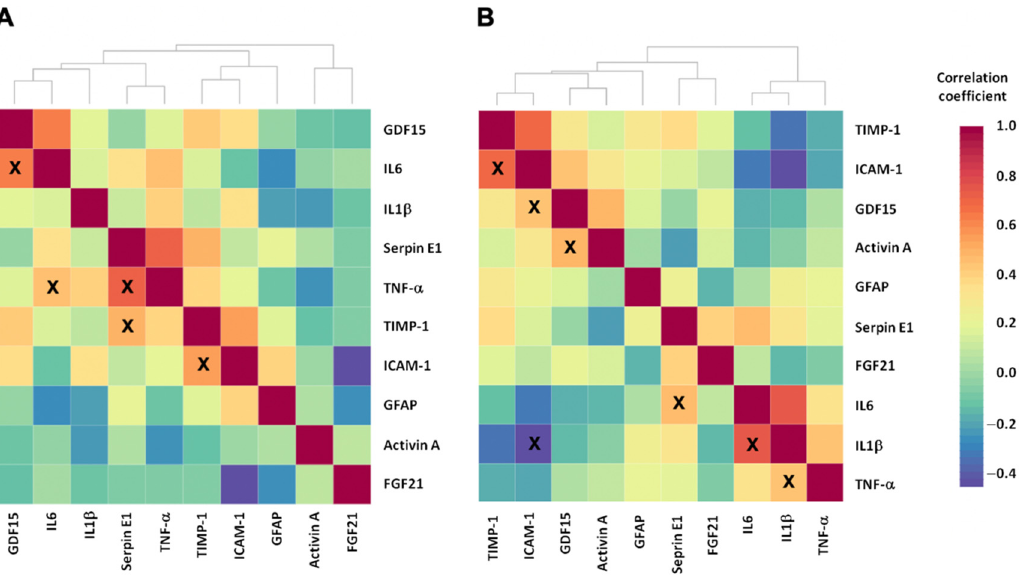
Figure 2. Correlation Matrix and Hierarchical Cluster Analysis of Serum Markers in the Two Participant Groups. Panel ( A ), participants with physical frailty and sarcopenia (PF&S); panel ( B ), participants without PF&S. Abbreviations: FGF21, fibroblast growth factor 21; GDF15, growth/differentiation factor 15; GFAP, glial fibrillary acidic protein; ICAM-1, intercellular adhesion molecule 1; IL, interleukin; TIMP-1, tissue inhibitor matrix metalloproteinase 1; TNF- α , tumor necrosis factor- α ; X indicates significant associations ( p < 0.05).